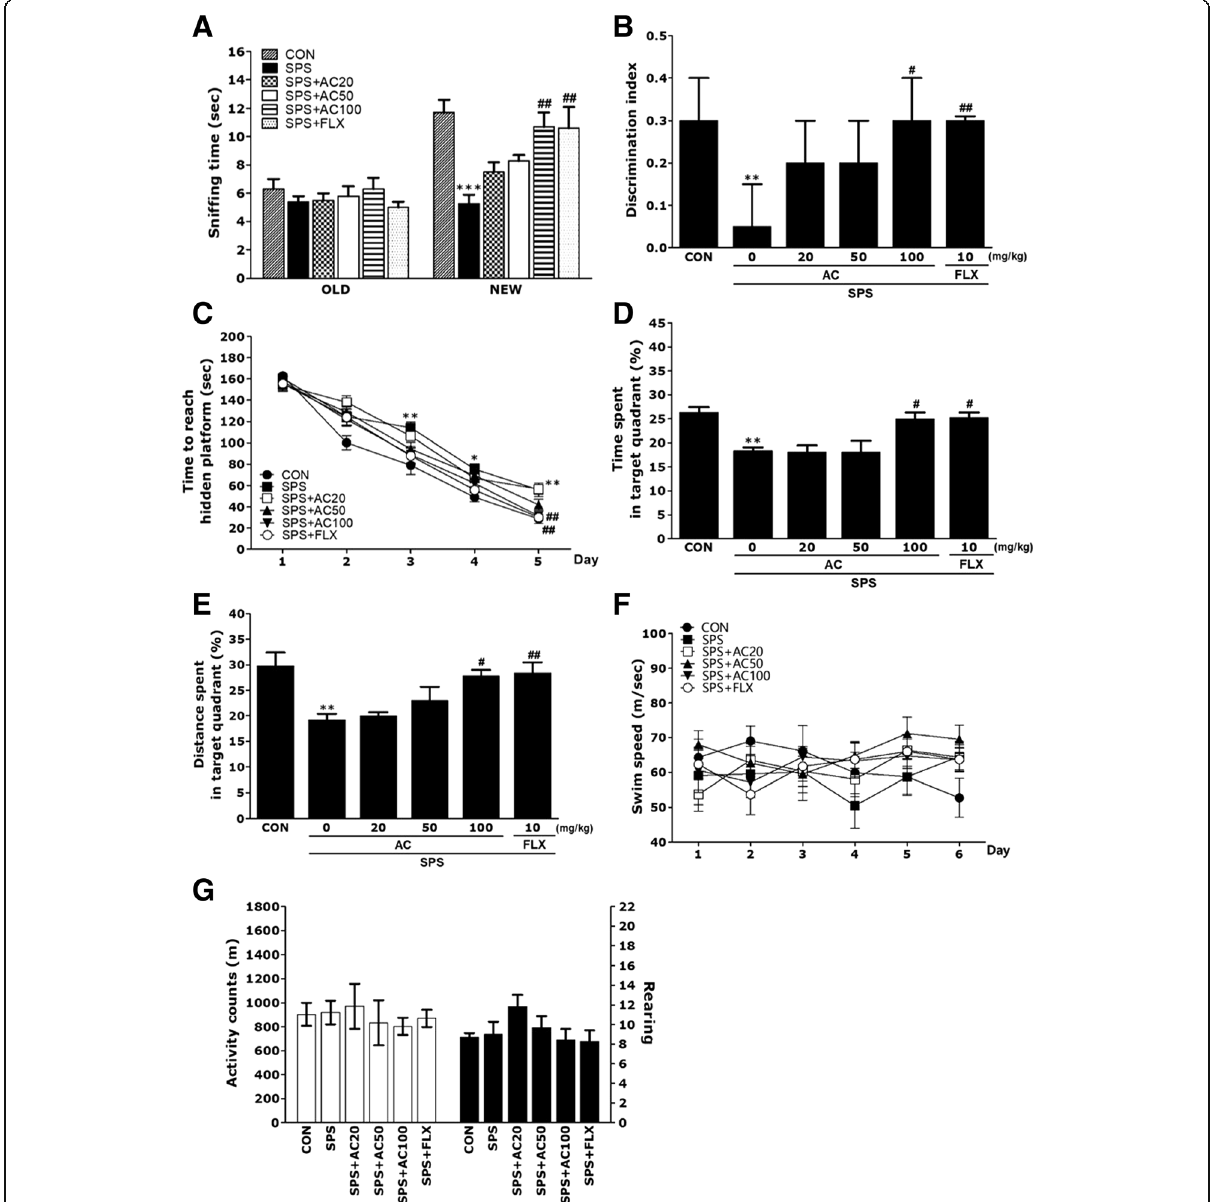
Fig. 4 The effects of AC on recognition memory were assessed using a novel ORT. The time spent sniffing familiar and novel objects during a 3- min choice trial ( a ) and the ability to discriminate ( b ) between familiar and novel objects were measured. The MWMW test was used to assess the effect of AC on spatial learning and memory. The time taken to escape (latency) from the water during acquisition trials featuring a submerged platform ( c ), the spent in the target quadrant ( d ), distance travelled in the target quadrant ( e ), and swimming speed ( f ) were the outcome measures. The OFT was to assess the effect of AC on locomotor activity and the total number of rearing behaviors ( g ) ( n = 6~7/group). * p < 0.05, ** p < 0.01, *** p < 0.001 vs. the CON group, # p < 0.05, # p < 0.05 vs. the SPS